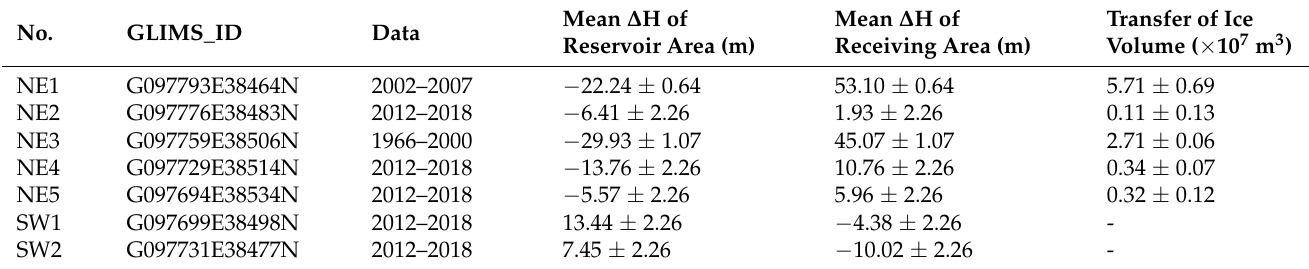
Table 5. Mean surface elevation changes of the reservoir area and receiving area and transfer of ice volume for studied